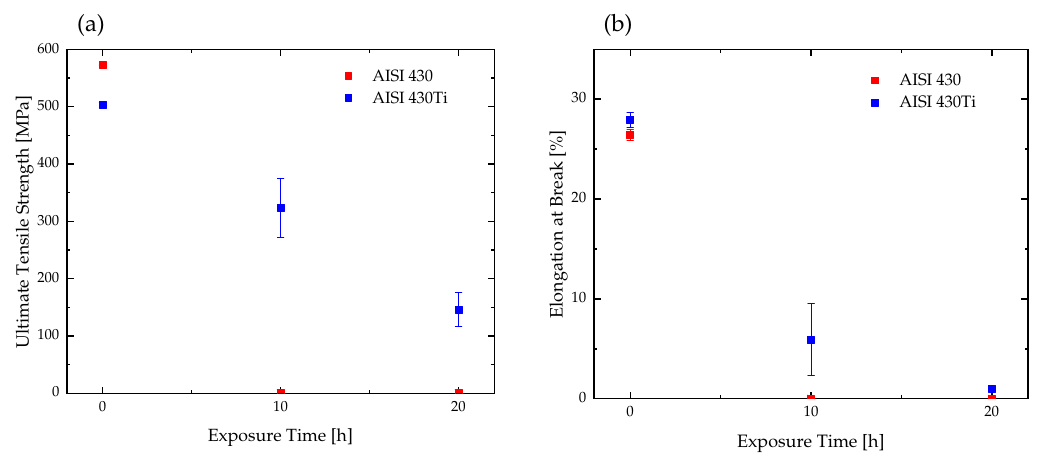
Figure 16. Mean values and SEM of ( a ) ultimate tensile strength and ( b ) elongation at break for AISI430 and AISI 430Ti as a function of exposure time to the corrosive environment, calculated from the results obtained at different energy inputs.